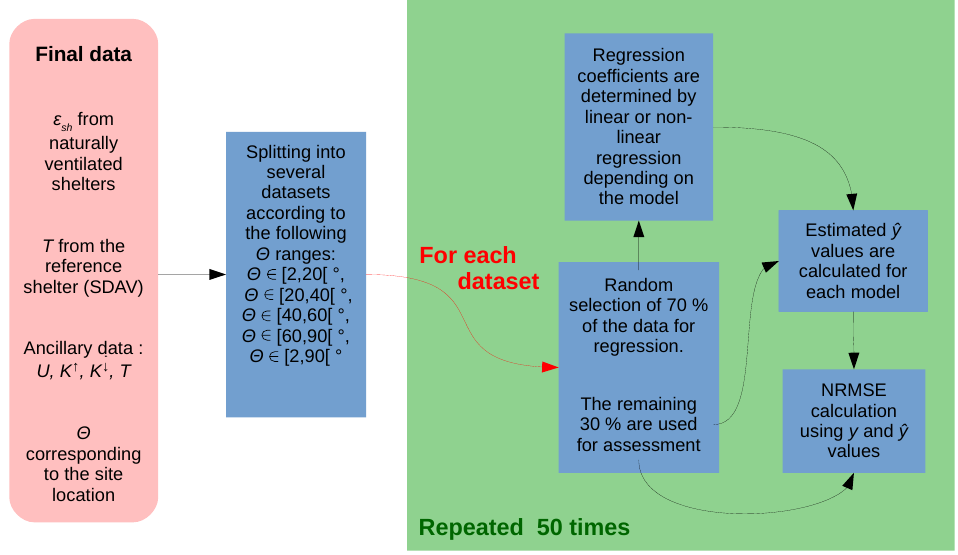
Figure 6. Processing chain used to assess the performance of each of the